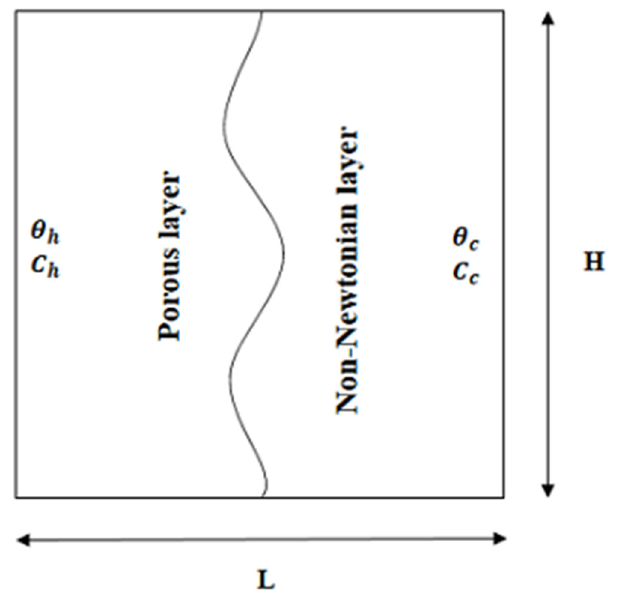
Figure 1. Schematic diagram.